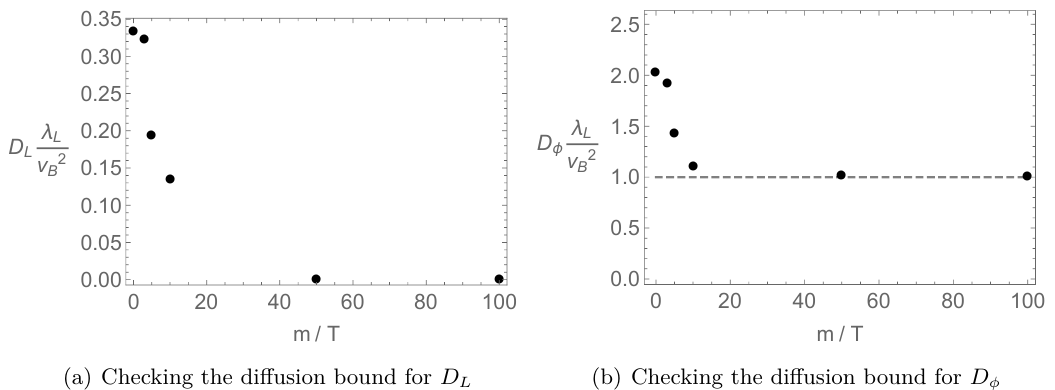
Figure 4 . The diffusion bounds of the SSB case for D L and D φ . λ L = 2 πT , the butterfly velocity v B is (3.6). The dashed line denotes the lower bound.